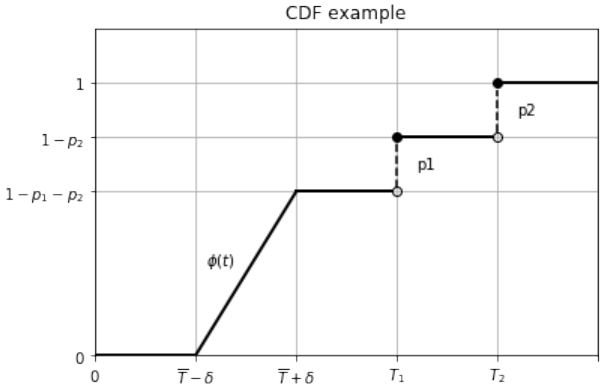
Figure 1. The example of discrete distribution of random time